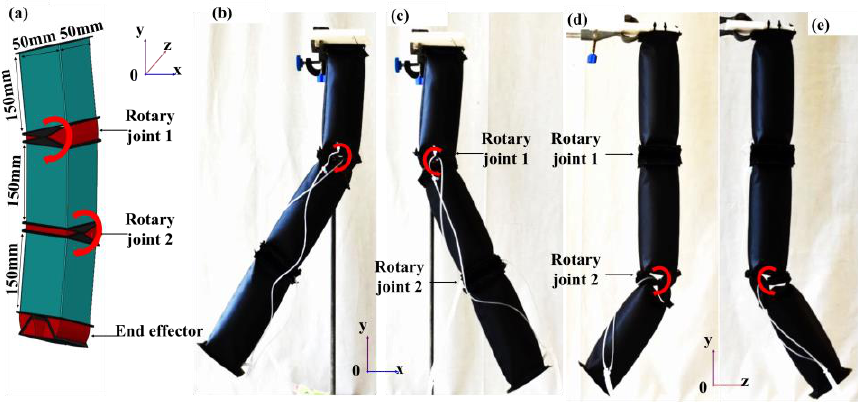
Figure 11. Position control step response.